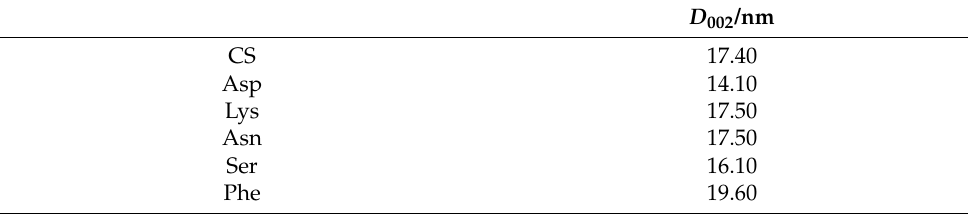
Table 2. Size of crystalline domains along the [002] direction of CaDHA formed after 60 min reaction time (150 min in the case of Ser) in the control system (CS) and in the presence of 5 mmol dm − 3 aspartic acid (Asp), asparagine (Asn), serine (Ser), lysine (Lys), and phenylalanine